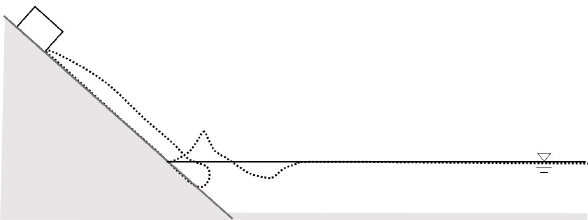
Figure 2. The sketch of the physical process of landslide-generated waves.